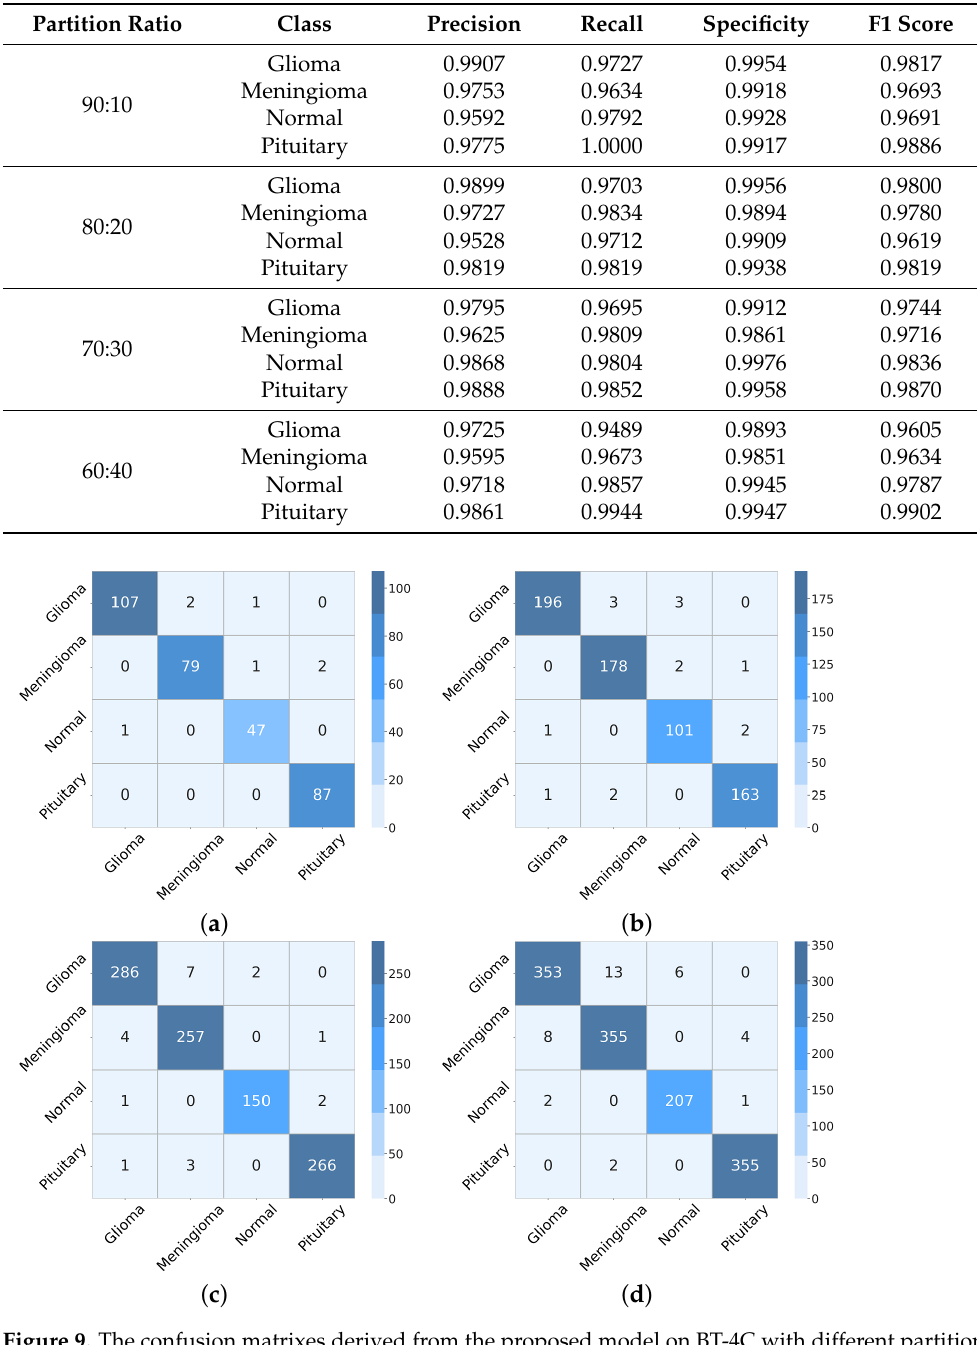
Figure 9. The confusion matrixes derived from the proposed model on BT-4C with different partition ratios. ( a ) 90:10, ( b ) 80:20, ( c ) 70:30, ( d )